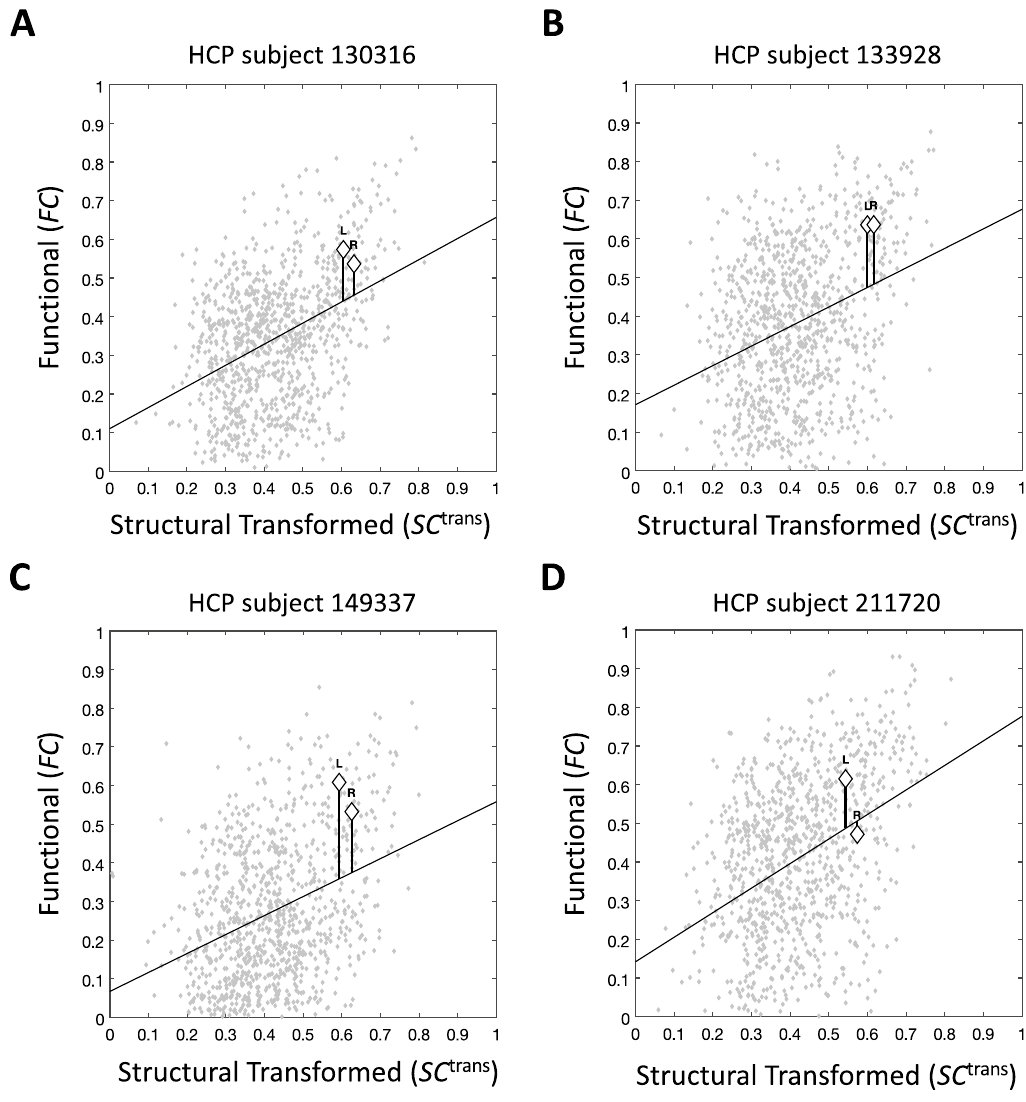
Figure 2. Scatterplots of functional connectivity, against structural connectivity that was transformed by MFCSC. Shown are scatterplots (data points in grey) and corresponding regression lines for four representative subjects from the Human Connectome Project dataset. To give an example of a bilateral pair that had significantly different FC-SC mismatch in each hemisphere, the data points for the left and right superior frontal - pars opercularis connections (frontal aslant tracts, or FATs) are indicated by diamonds. The y-axis difference of each data point from the regression line is equal to its FC-SC mismatch value, i.e. mFCSC uv,k . The differences of the example data points from the regression line are indicated by vertical lines. HCP Human Connectome Project, L left unilateral connection, R right unilateral